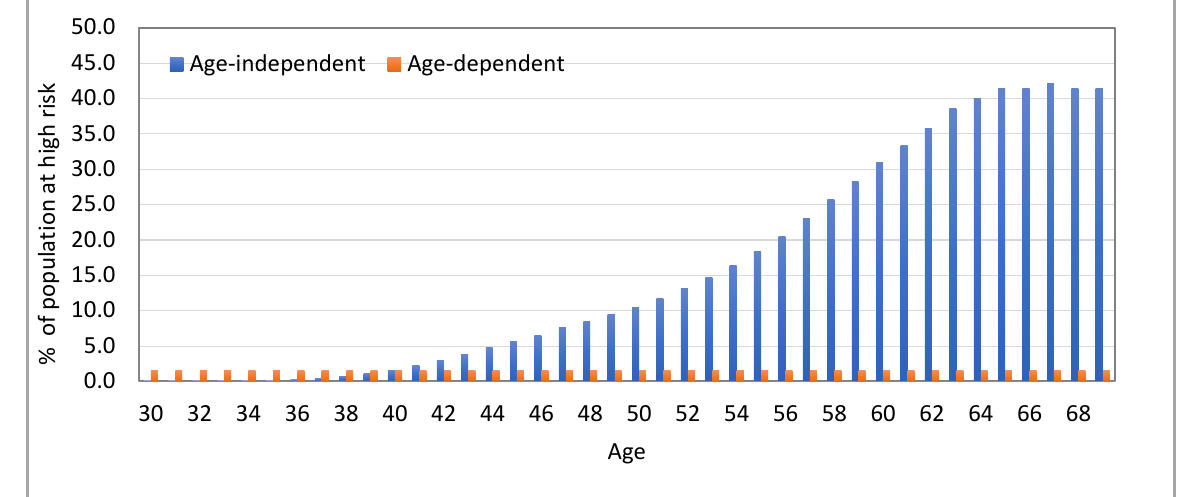
Figure 2. Proportion of women in Canada considered at high risk of breast cancer, considering age-dependent and age-independent 10-year absolute risk thresholds equivalent to a remaining lifetime risk of 25% from age 40.